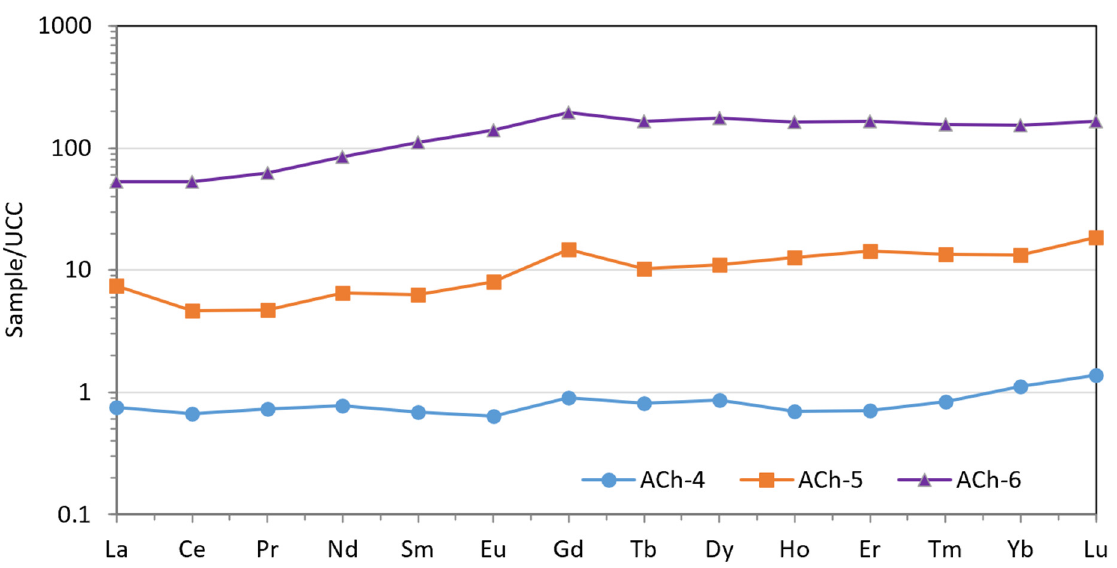
Figure 8. REE distribution patterns of weakly oxidized coal (ACh-4), oxidized coal (ACh-5), and sooty coal at the contact with the roof conglomerates (ACh-6); normalized for UCC according to Taylor and McLennan